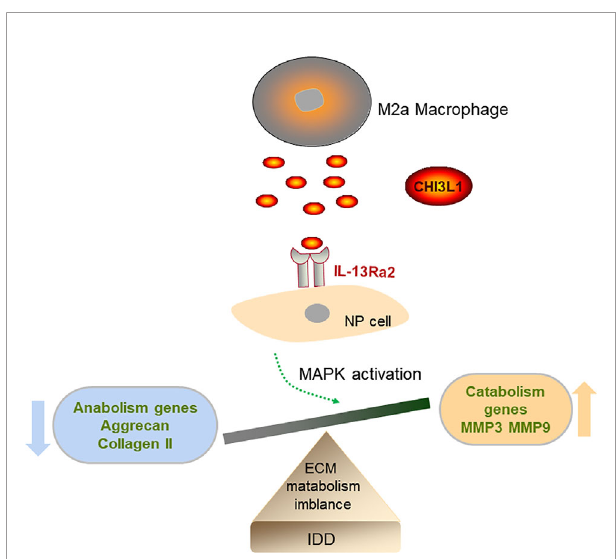
FIGURE 7 | Diagram of the possible mechanism that M2a macrophage promotes intervertebral disc degeneration (IDD). M2a macrophage-secreted CHI3L1 promoted the expression of catabolism genes (MMP-3 and MMP-9) and suppressed the expression of anabolism genes (aggrecan and collagen II) in NP cells via activation of IL-13R a 2/MAPK